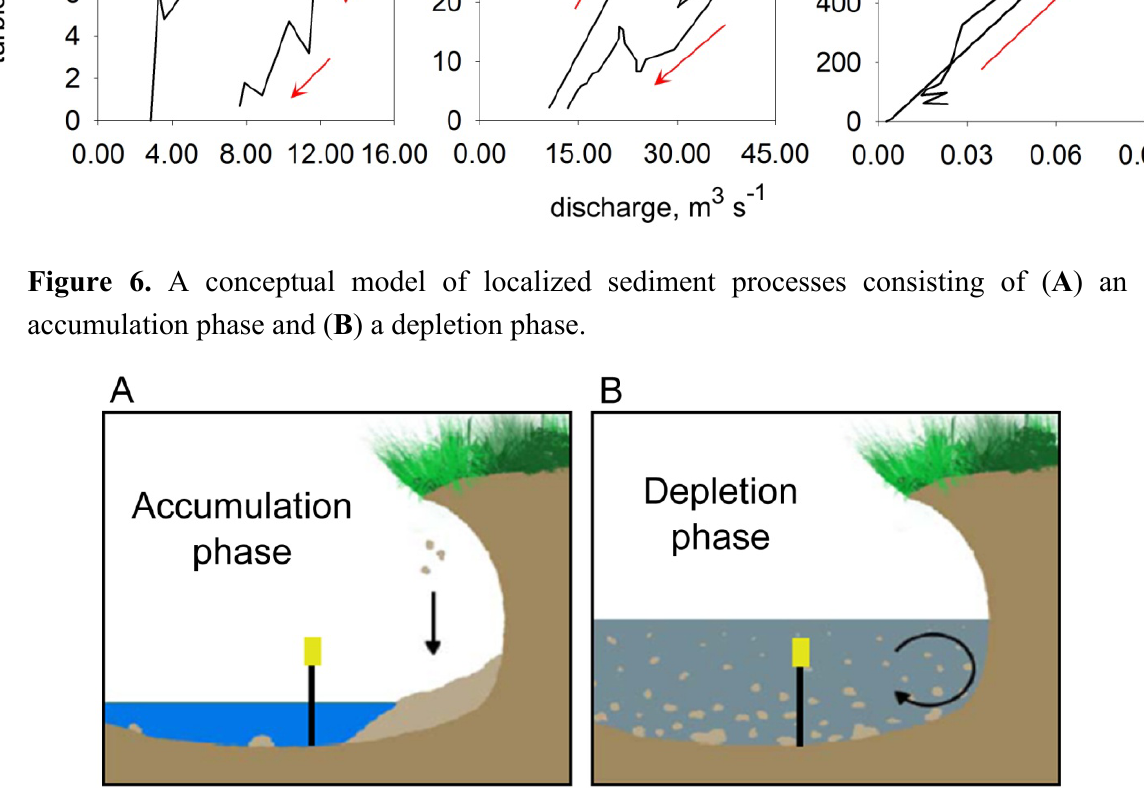
Figure 7. Bank pin surveys from ( A ) Big Sandy and ( B ) Speckerman showing sediment accumulation at toe of bank